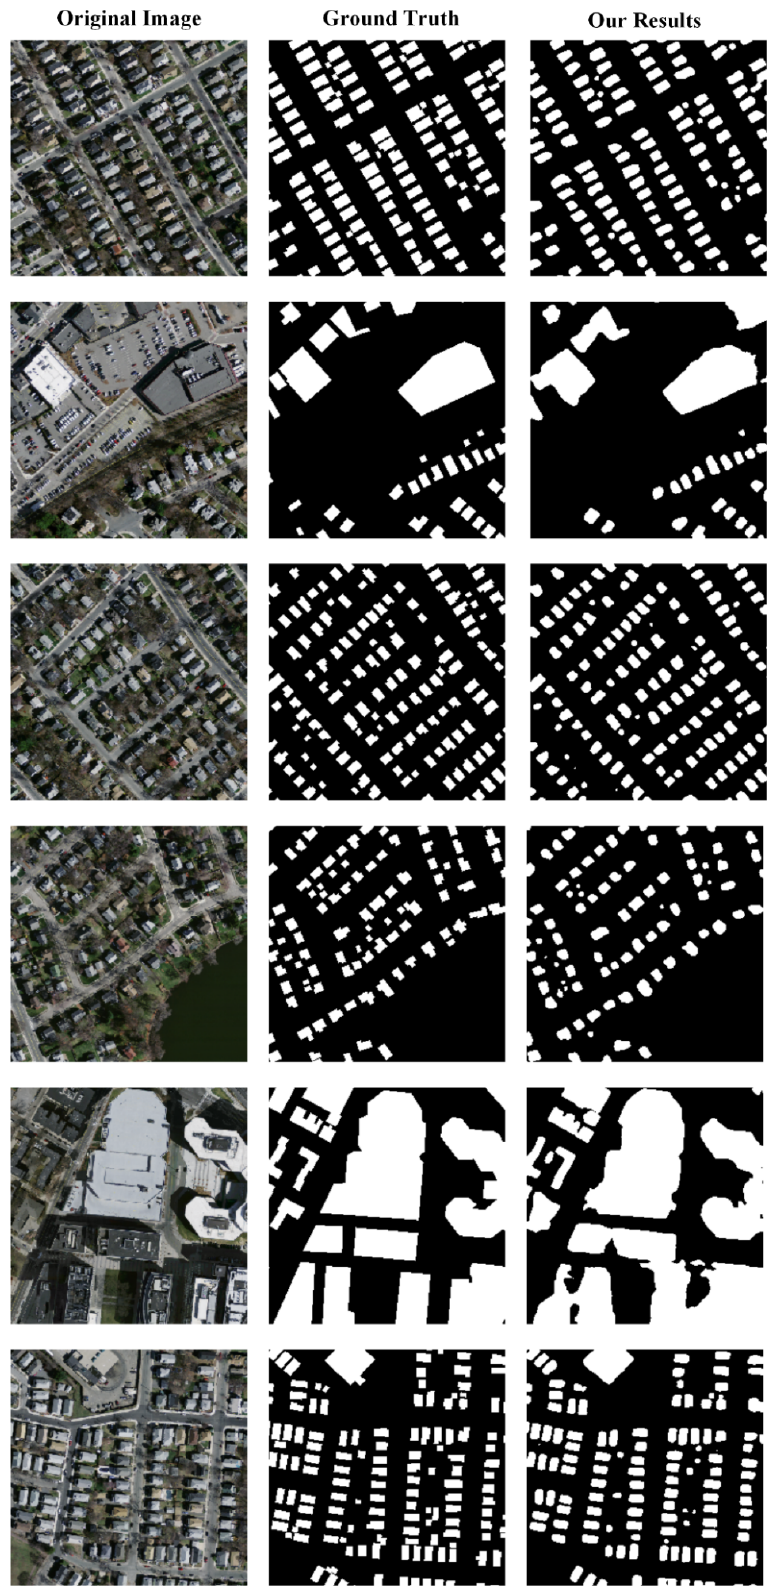
Figure 7. Building extraction results by our method tested on the Massachusetts Building dataset. The first, second and third columns are the original images, ground truths and our extraction results, respectively.